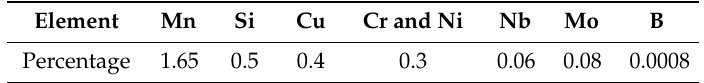
Table 1. Chemical composition of low-carbon constructional steel S235JR.